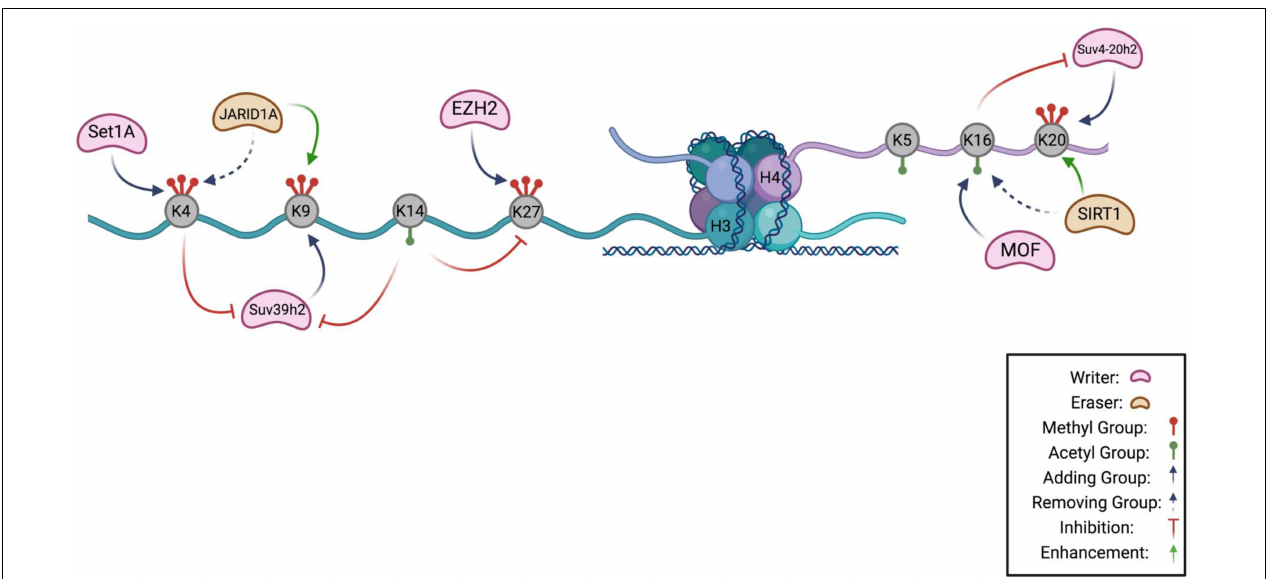
FIGURE 1 | Histone Code Hypothesis. A schematic highlighting the known interactions between chromatin modifying enzymes on the H3 and H4 tail as a potential hypothesis of the histone code in quiescence. Lysines that can be methylated or acetylated are gray, and are indicated to have methyl groups (red) or acetyl groups (green). H3K4 can be methylated by methyltransferase, Set1A, and demethylated by JARID1A, a demethylase. Methylation of lysine 4 prevents the methylation of H3K9 by inhibiting Suv39h2, the methyltransferase of lysine 9. Suv39h2 activity can also be prevented by acetylation of H3K14. Removal of H3K4 methylation by JARID1A enhances H3K9 methylation. On the H4 tail, MOF acetylates lysine 16 which inhibits activity of Suv4-20h2 in methylating H4K20. Removal of an acetyl group from H4K16 by SIRT1 enhances H4K20 methylation (Figure made in